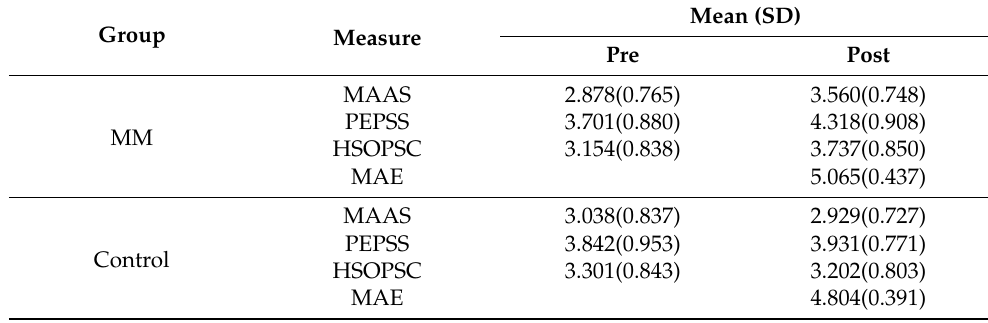
Table 2. Descriptive statistics.